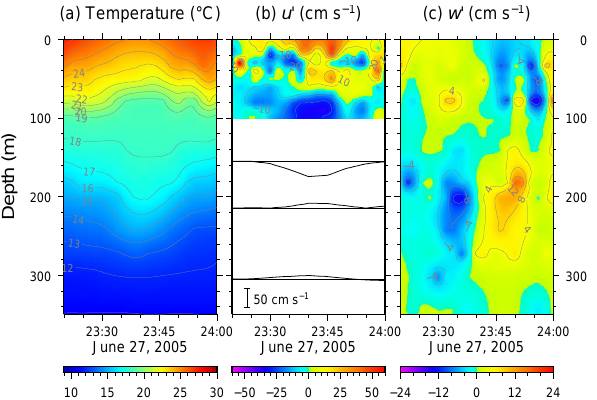
Fig. 3. Same as Fig. 2 except from 22:40 to 23:20UTC on 9 July 2005. amplitude was much smaller than that of u 0 . Therefore, the primary propagation direction of this convex wave was westward, consistent with mode-1 waves observed in the area (Ramp et al., 2010). The corresponding depths of the local maximum and minimum w 0 were near 80 m and 200 m, respectively (Fig. 2c). The positions of the local maximum/minimum w 0 were close to the positions of the two u 0 nodal